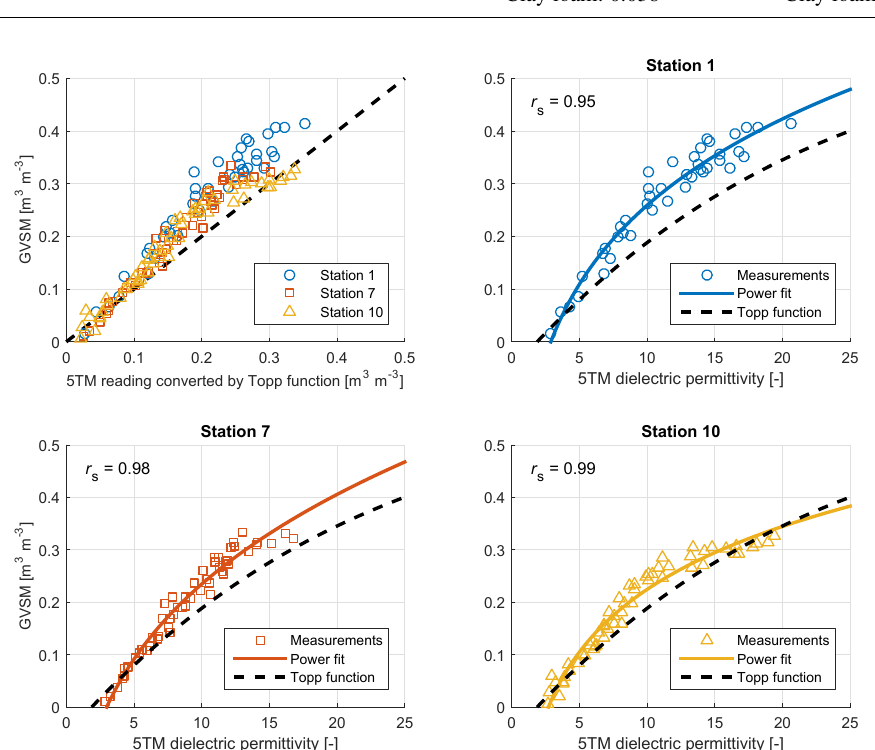
Figure 7. Decagon 5TM dielectric permittivity readings against GVSM, measured in the laboratory in soil from a selection of fields. The power fits are used as calibration functions for converting the relative dielectric permittivity measurements by 5TM sensors to volumetric soil moisture